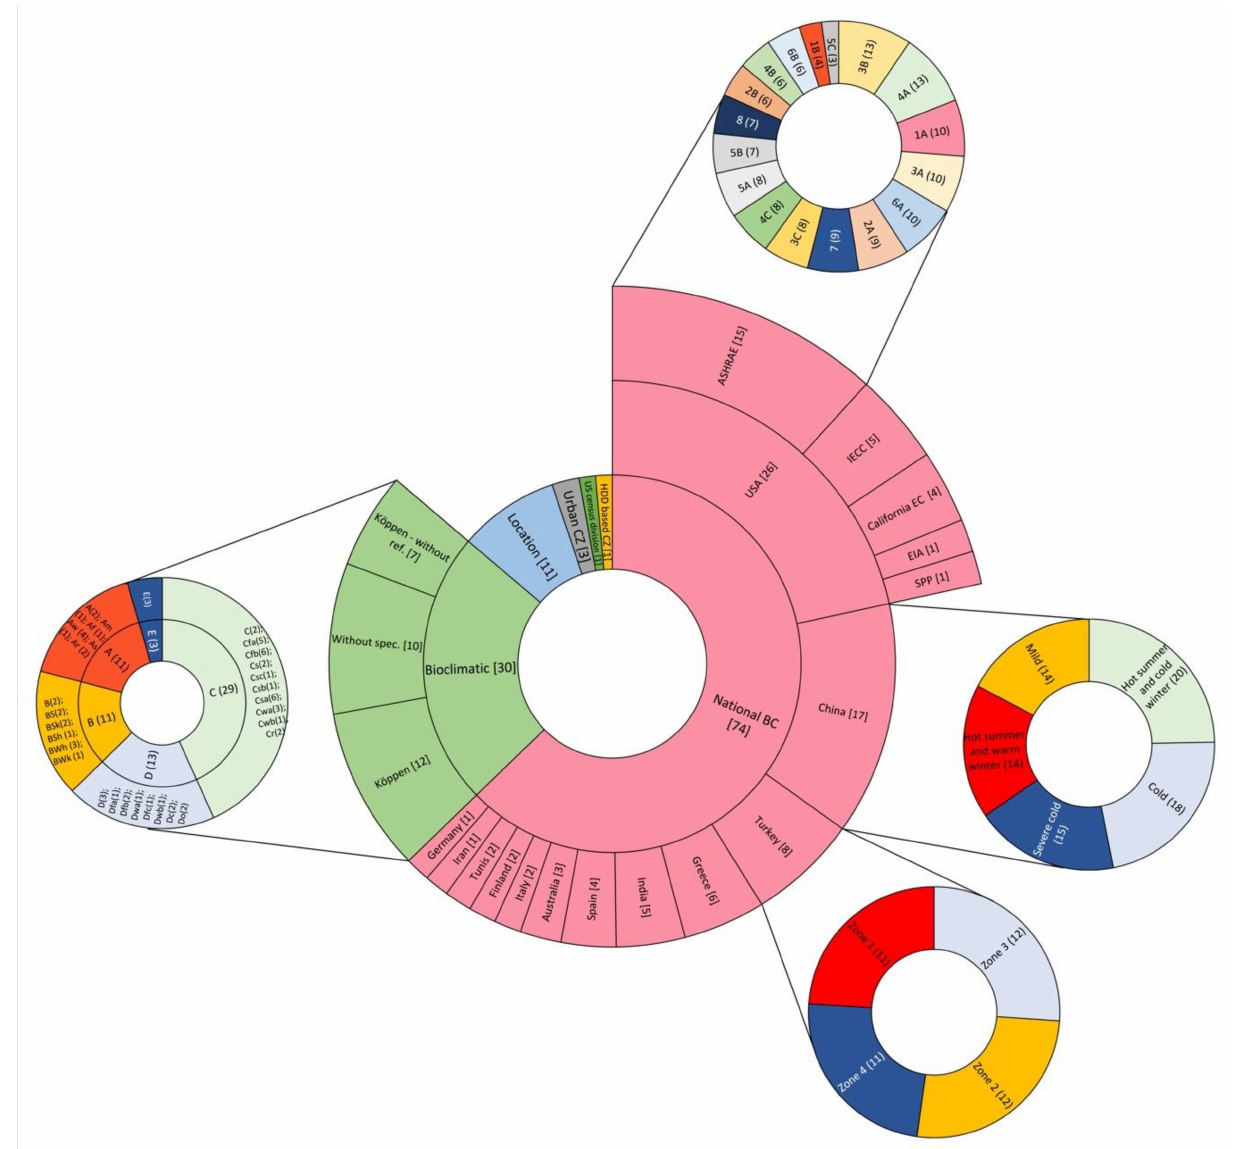
Figure 7. Main climate zonings [number of times of use] in analysed works and the most used climate zones (the number of geographical points corresponding to each